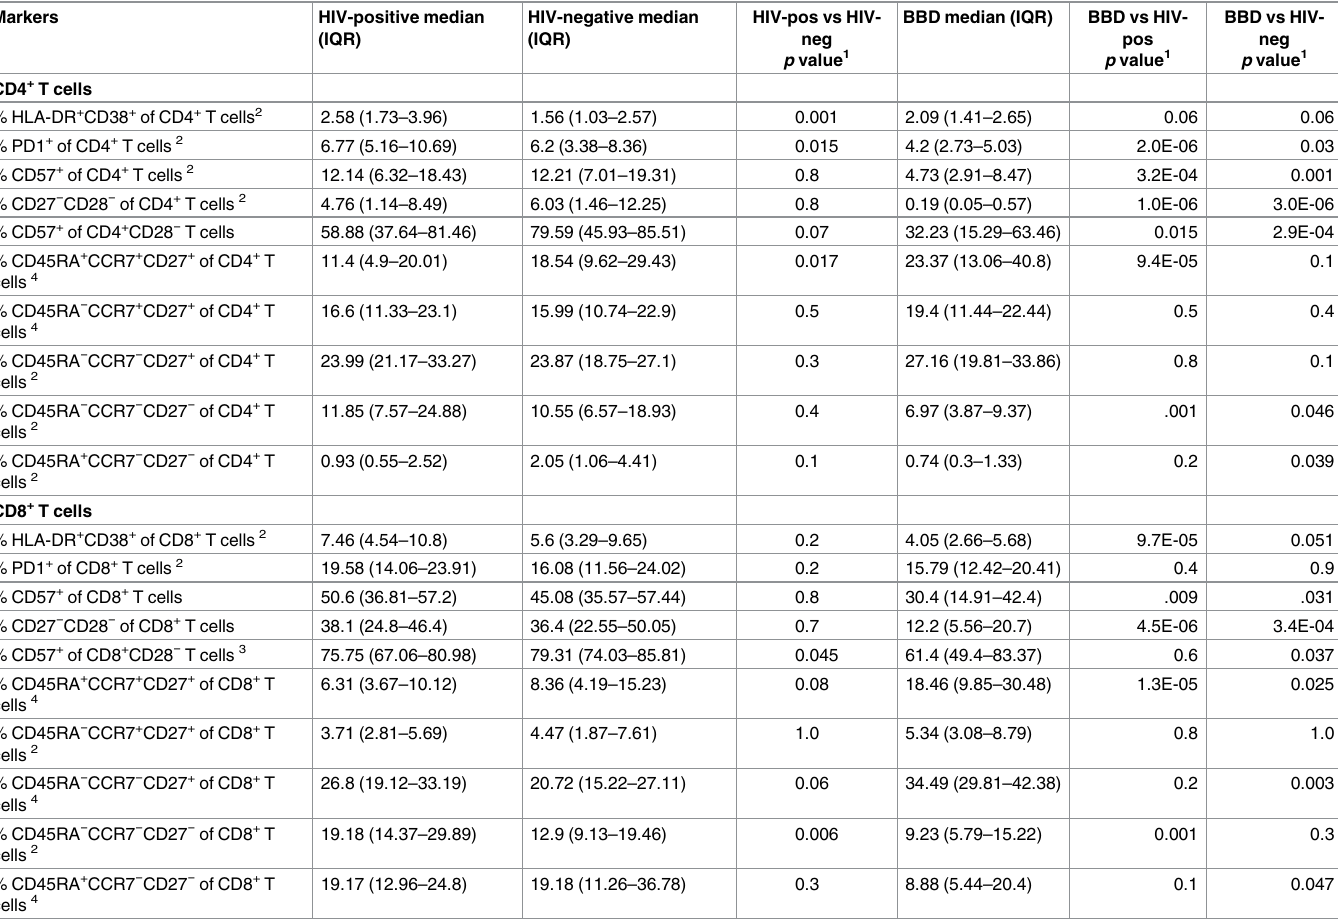
Table 2. T cell activation, exhaustion and differentiation in HIV-positive and HIV-negative COBRA participants and blood bank